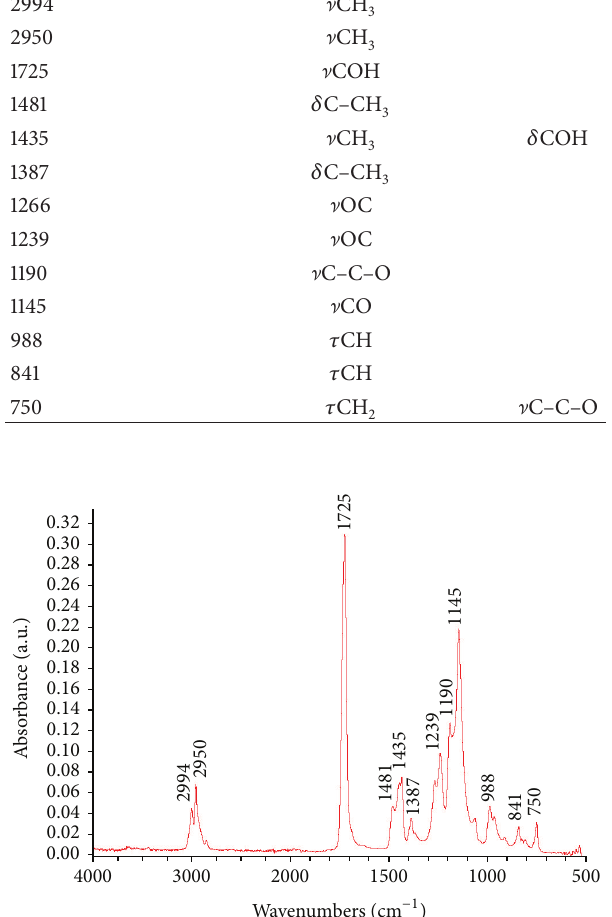
Figure 7: Infrared spectrum (4000–500 cm −1 ) of undoped precipi- tated